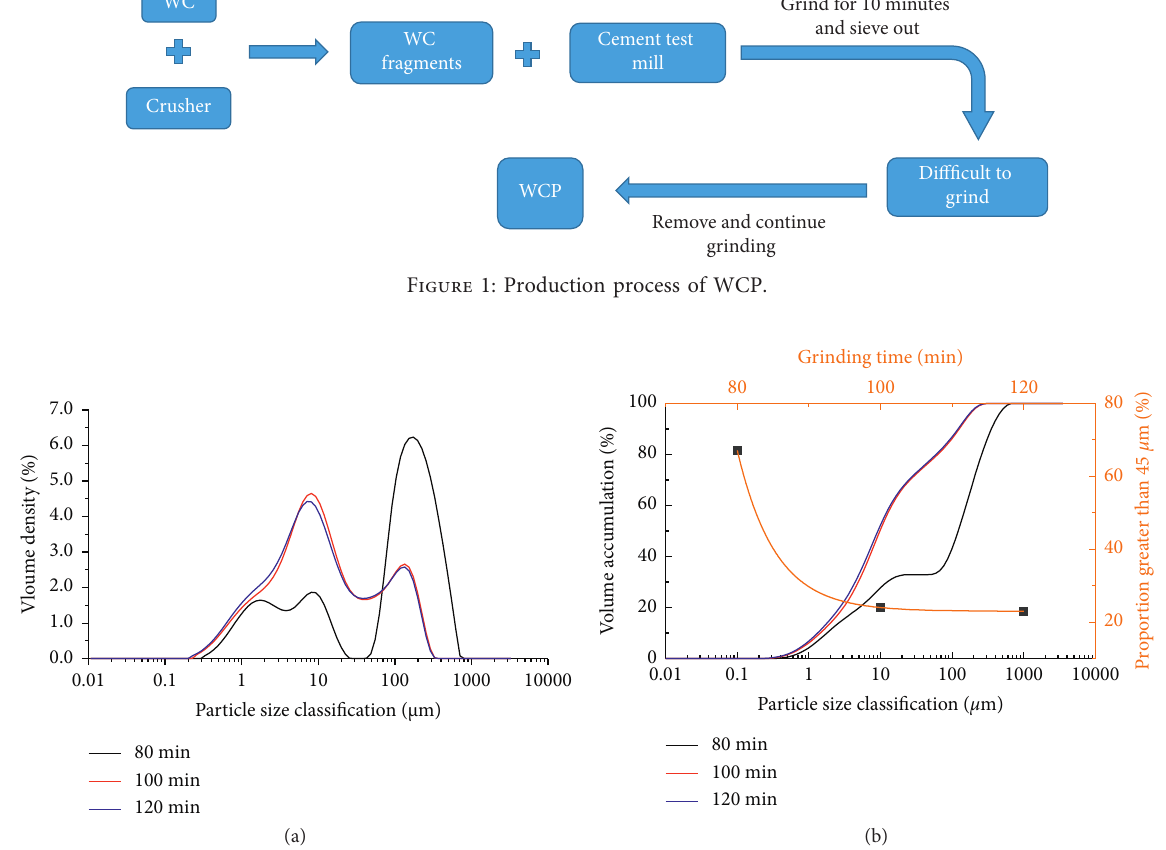
Figure 2: Particle size classification of WCP at different grinding times: (a) volume density, (b) particle size accumulation, and the proportion of particles greater than 45 μ